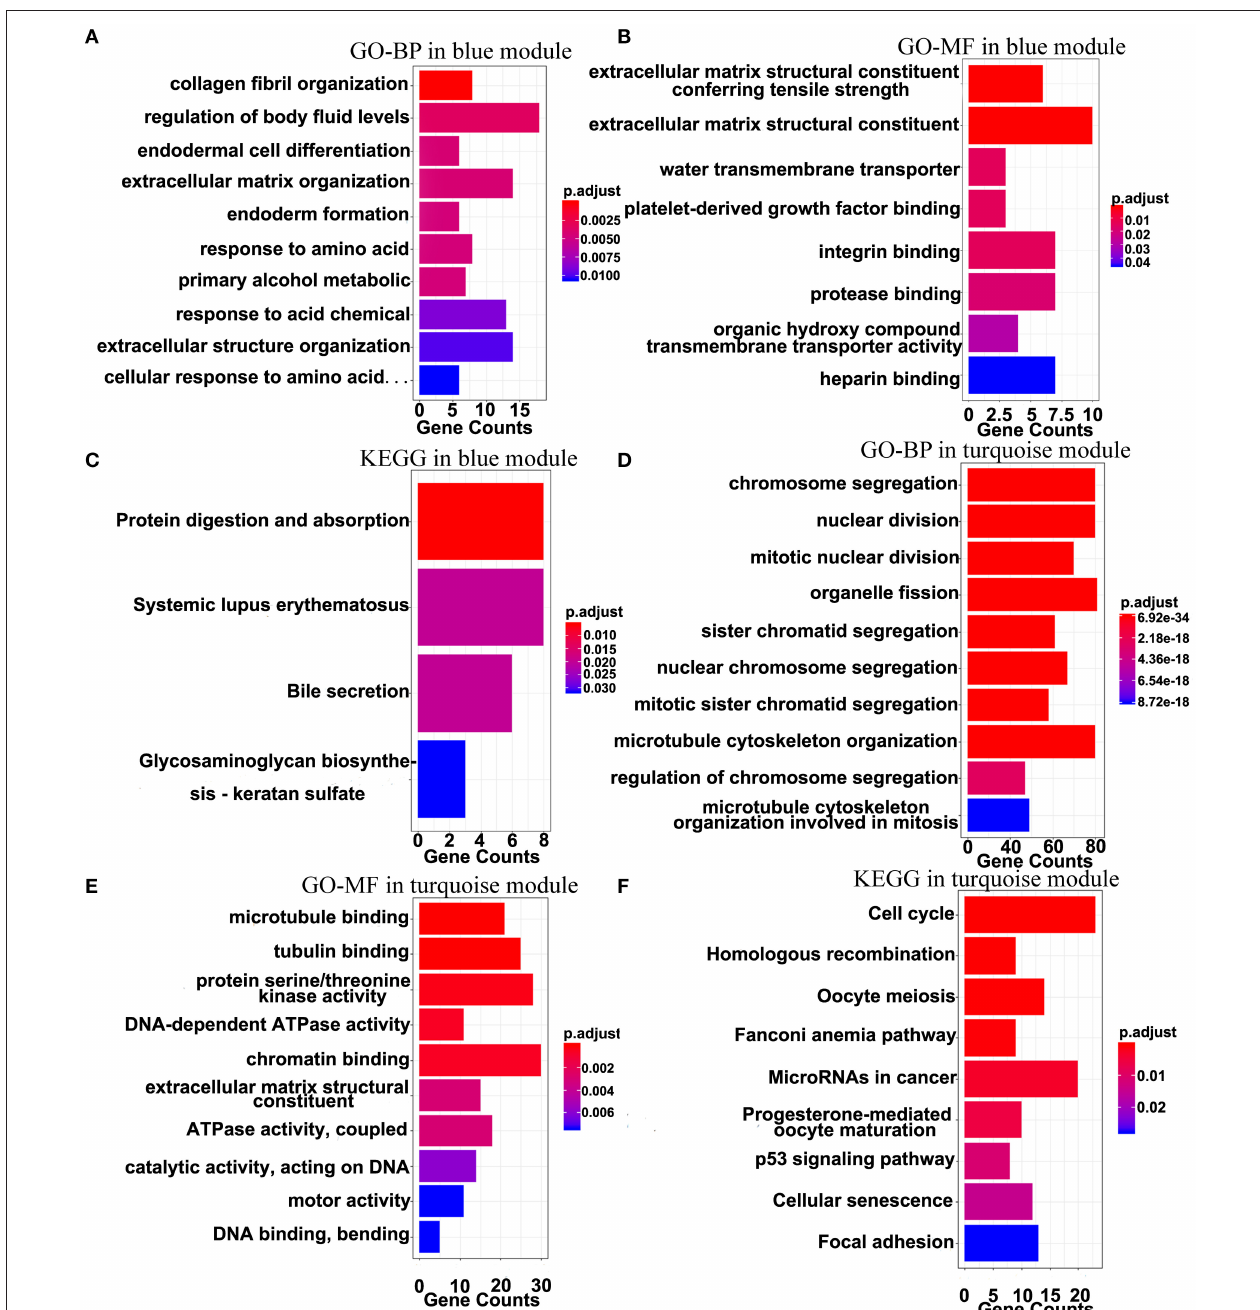
FIGURE 9 | Gene-enrichment analyses of genes in the blue module and the turquoise module. (A) Top 10 GO-BP terms in the blue module. (B,C) Significant GO-MF and KEGG pathway terms in the blue module. (D,E) Top 10 GO-BP and GO-MF terms in the turquoise module. (F) Significant KEGG terms in the turquoise module. P -value was adjusted by the FDR method and p < 0.05 was